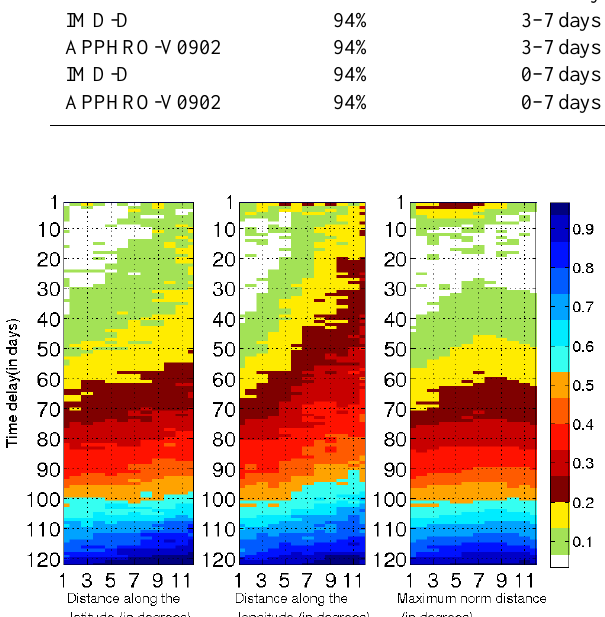
Fig. 8: Shannon entropy for the distribution of each delay for Fig. 8. Shannon entropy for the distribution of each delay for all